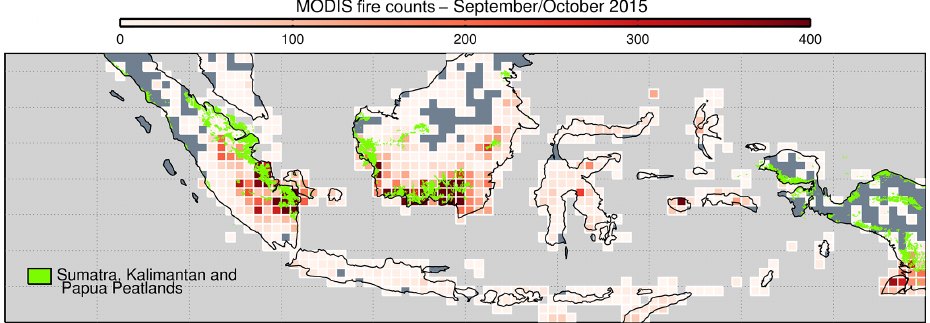
Figure 2. MODIS fire counts for September–October 2015 over the Indonesia, gridded into 0.5 ◦ × 0.5 ◦ boxes. Also overlaid are the locations of known peatlands in Sumatra (left), Kalimantan (centre) and Papua